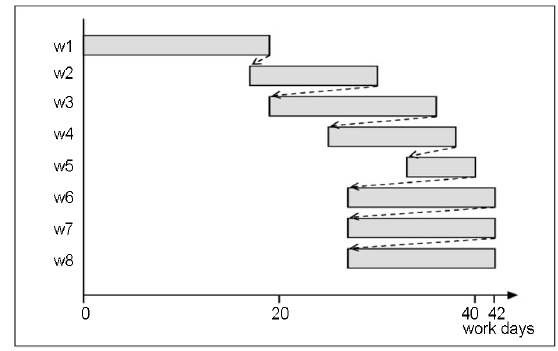
Fig. 6. Scheduling example for a road segment s